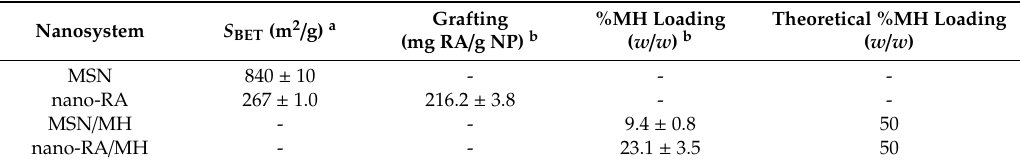
Table 1. Summary of physical data of the tested nanomaterials.